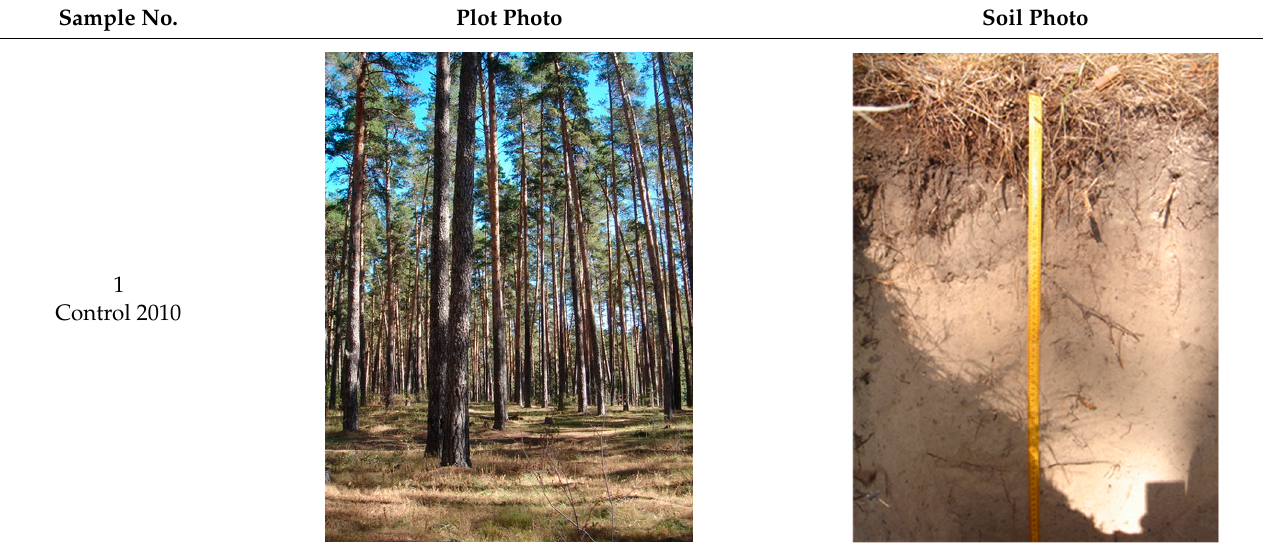
Table 2. The photo description of studied plots and soils. Sample No. corresponds to Table 1. Sample